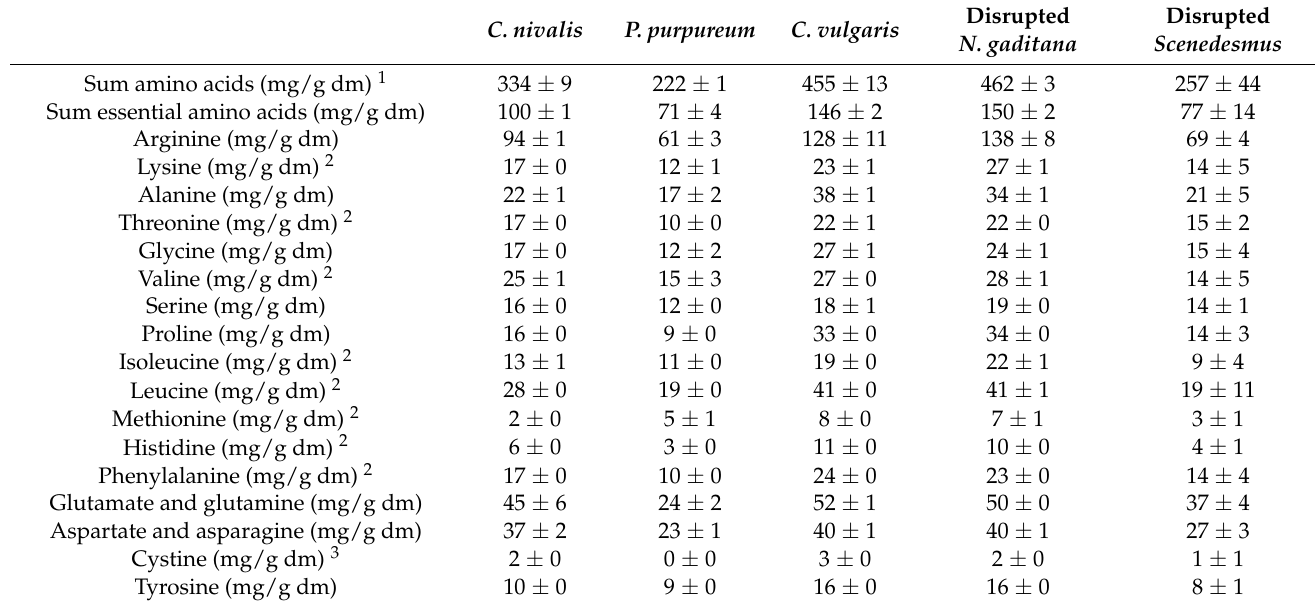
Table 3. Amino acid